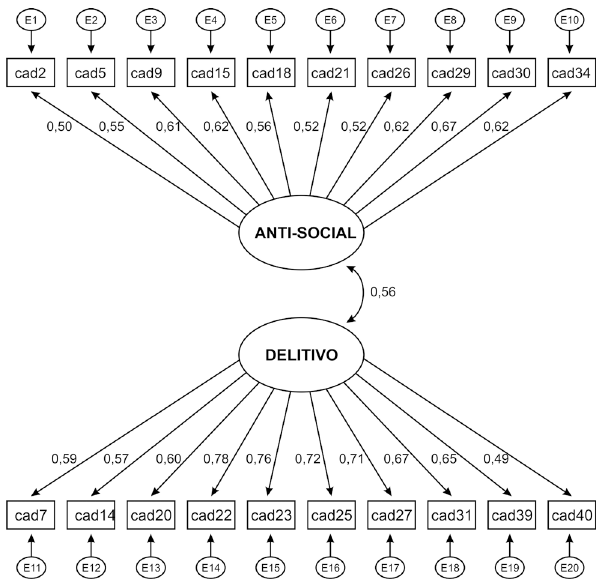
Figura 1 . Estrutura Bi-fatorial do